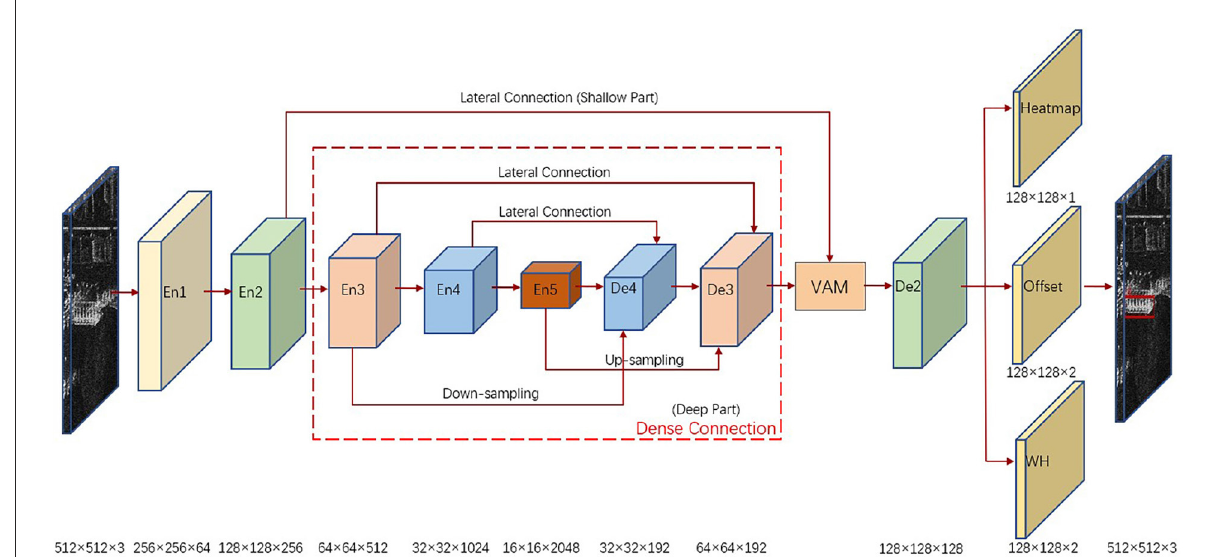
FIGURE1 Overall architecture of the proposed algorithm. The deep part of the network is densely connected, the shallow part of the network is processed by the visual attention module (VAM), and the prediction head outputs heatmap, target center offset, and constrained target width and height.